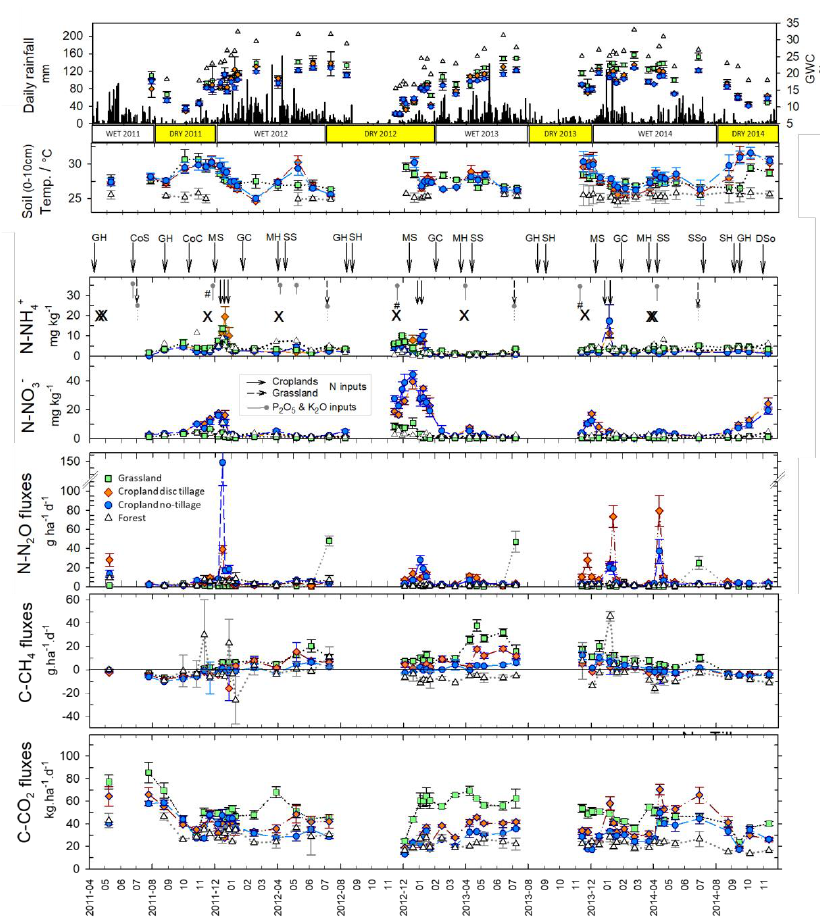
Figure 4. Daily rainfall, soil temperature (0–10 cm), soil gravimetric water content (0–15 cm), ammonium (NH 4 + ) and nitrate (NO 3 − ) contents (0–15 cm), fluxes of N 2 O, CH 4 , and CO 2 for forest, grassland (G), cropland with disc tillage (DT), and cropland with no-tillage (NT) from May 2011 to November 2014 at the Combi experimental site. In grassland, CO 2 emissions included aboveground autotrophic respiration. GC: Regeneration cutting in G plots; GH: Grass harvest in G plots; CoS: Seeding of Crotalaria and Stylosanthes cover; CoC: Cutting of Crotalaria and Stylosanthes (residues were left on the soil surface); MS: Maize seeding; MH: Maize harvest; SS: Soybean seeding; SH: Soybean harvest; Sso: Sorghum seeding; DSo: Chemical destruction of sorghum. N inputs are 50–60 kg ha − 1 for each arrow except for croplands on 26 December 2012 (80 kg ha − 1 ) and on 26 December 2013 and 06 January 2014 (75 kg ha − 1 ). P 2 O 5 and K 2 O inputs for each symbol are 60–80 kg ha − 1 , except in April and May 2012 (38 kg ha − 1 ). Plain lines are for croplands and dashed lines are for grassland. X corresponds to disc tillage practice in the DT plots. # corresponds to dolomite inputs into all agricultural systems (1 t ha − 1 , 30% CaO and 20%